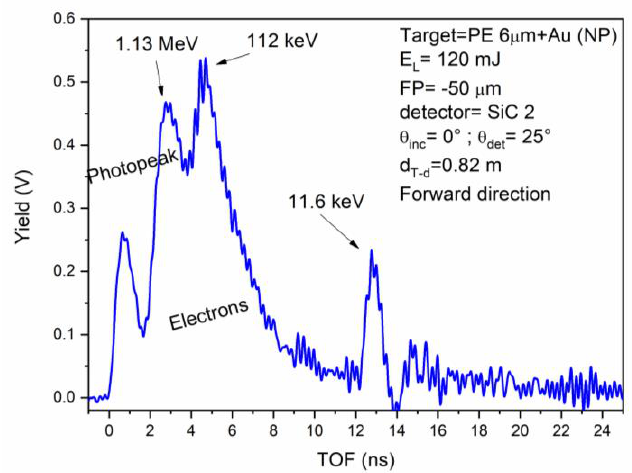
Figure 6. SiC-TOF forward spectrum obtained by irradiating a thin foil of PE with Au NPs, 6 μm thick in the TNSA regime, and low laser contrast.